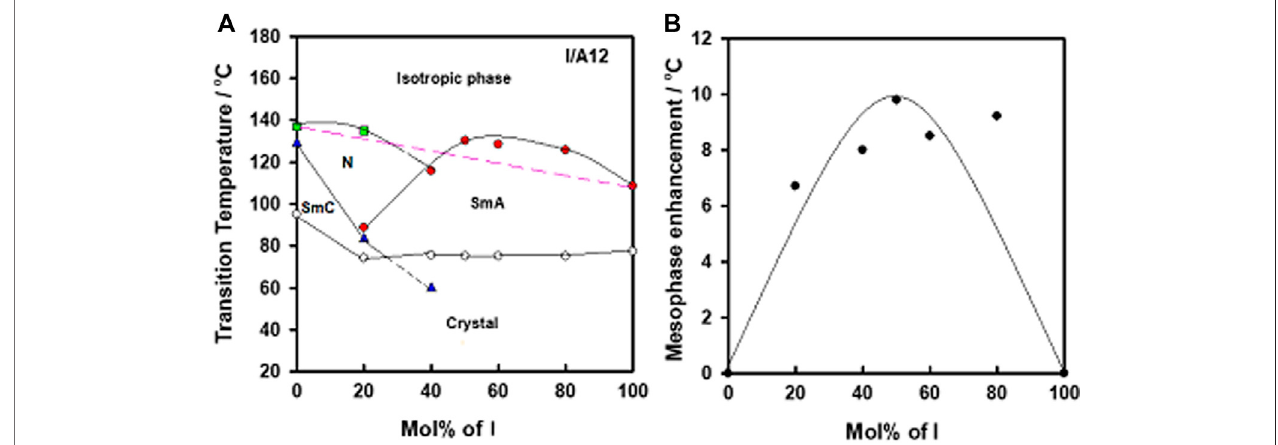
FIGURE 6 | (A) Binary phase diagram of I/A12 SMHBC, and (B) the relation of the mesomorphic enhancement and the mixture compositions of base, I.